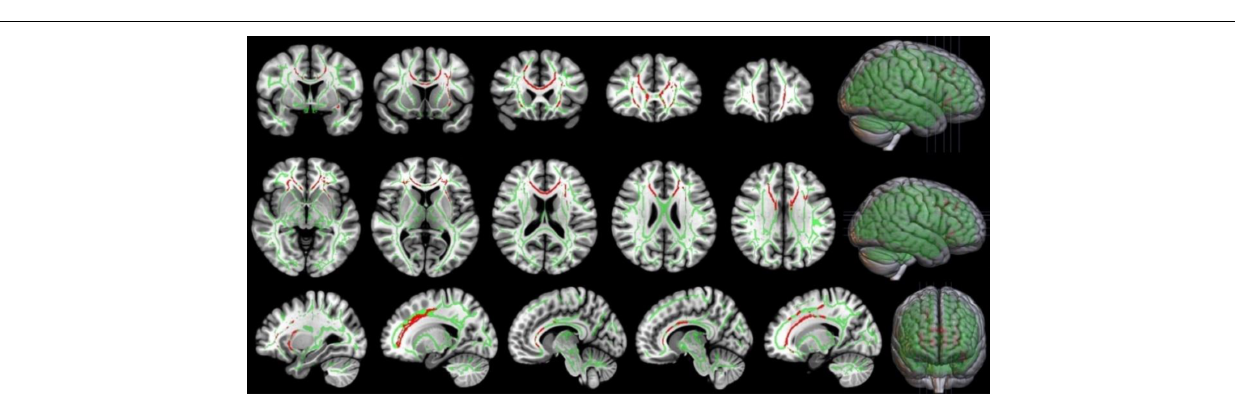
FIGURE 5 | Comparison of FA in local brain regions of the HA and LA participants. Red represents clusters of brain regions with reduced FA values after chronic hypoxia exposure. Green represents the average FA bundle skeleton template. TBSS: HA < LA ( p < 0.05, TFCE corrected). Threshold-Free Cluster Enhancement, TFCE, is a Multiple comparison correction method. By this method, the FA values of the voxels on the fiber bundle skeleton of the two groups were compared, and the regions with significant inter-group differences were highlighted.